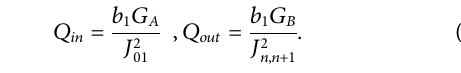
Frontiers in Physics |